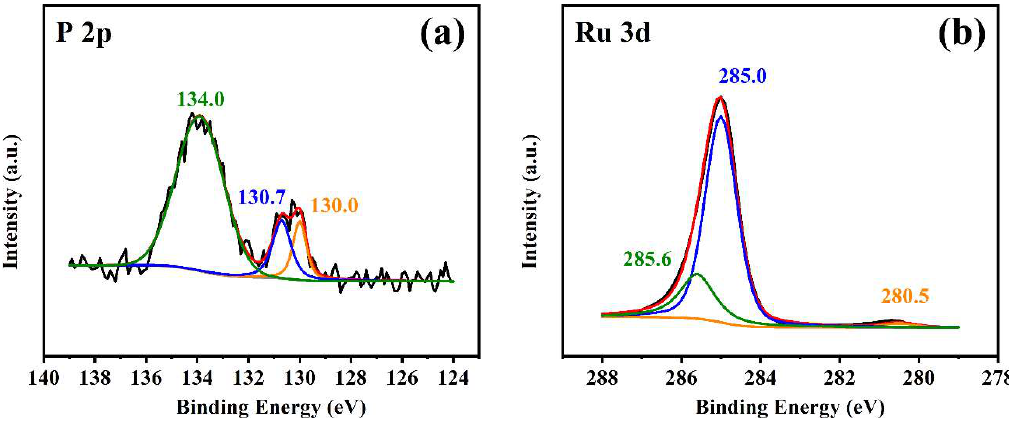
Figure 3. XPS spectra of P 2p ( a ) and Ru 3d ( b ) of Ru 2 P-BM-C.